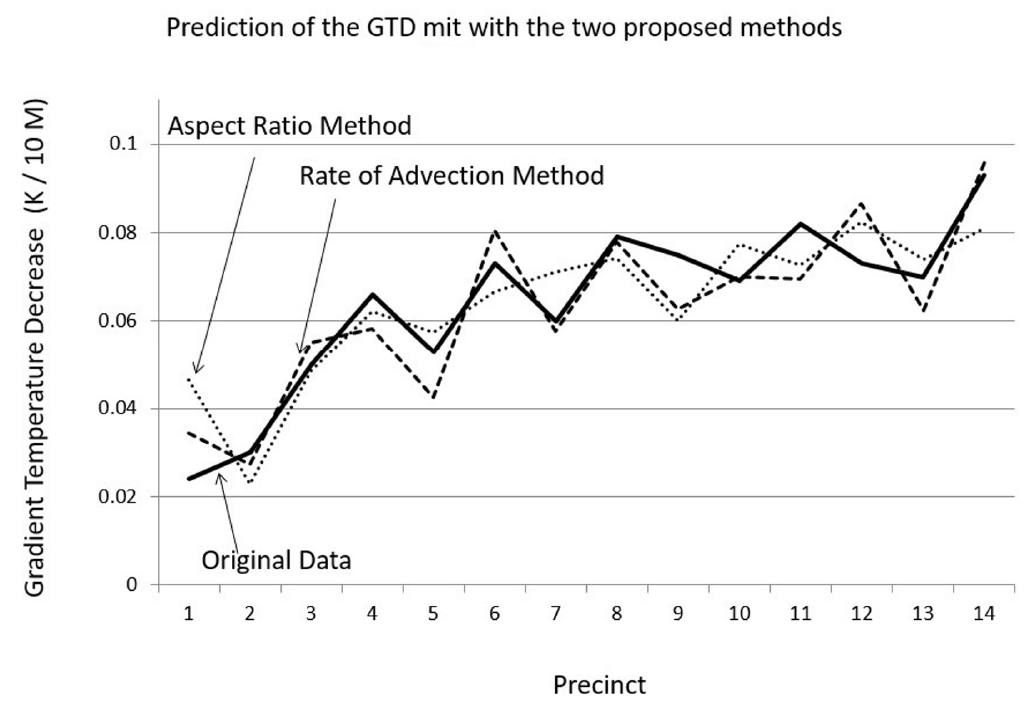
Figure 15. Prediction of the GTD mitigation for the unmitigated with the two proposed methods. The advection rate in the precincts is highly dependent on the canyon orientation and aspect ratio. The wind speed in canyons with an axis vertical or oblique to the wind direc- tion presents a lower wind speed is lower compared to wind speed in canyons with a parallel axis to the wind direction. This depends highly on the aspect ratio, ( H/W ), of the canyons, as derived by Oke [45]. For canyons vertical or oblique to the wind direction, a high H/W value > 0.8 signifies that the flow is under a skimming regime and corresponds to a local vortex inside the canyon, and a bypass of the flowing air above the height of the buildings. For H/W values between 0.8 and 0.3, the flow is the wake interface, and for lower values is isolated roughness [45]. For all canyons of the precincts that have their axis vertical or slightly oblique to the wind direction, a strong correlation between the average wind speed in the canyon, V average, and the aspect ratio ( H/W , is found (Figure 16). The relation has the form: 𝐻 𝑉 = 0.2046 ∙ (cid:3436) (cid:3440) (cid:3028)(cid:3049)(cid:3032)(cid:3045)(cid:3028)(cid:3034)(cid:3032) 𝑊